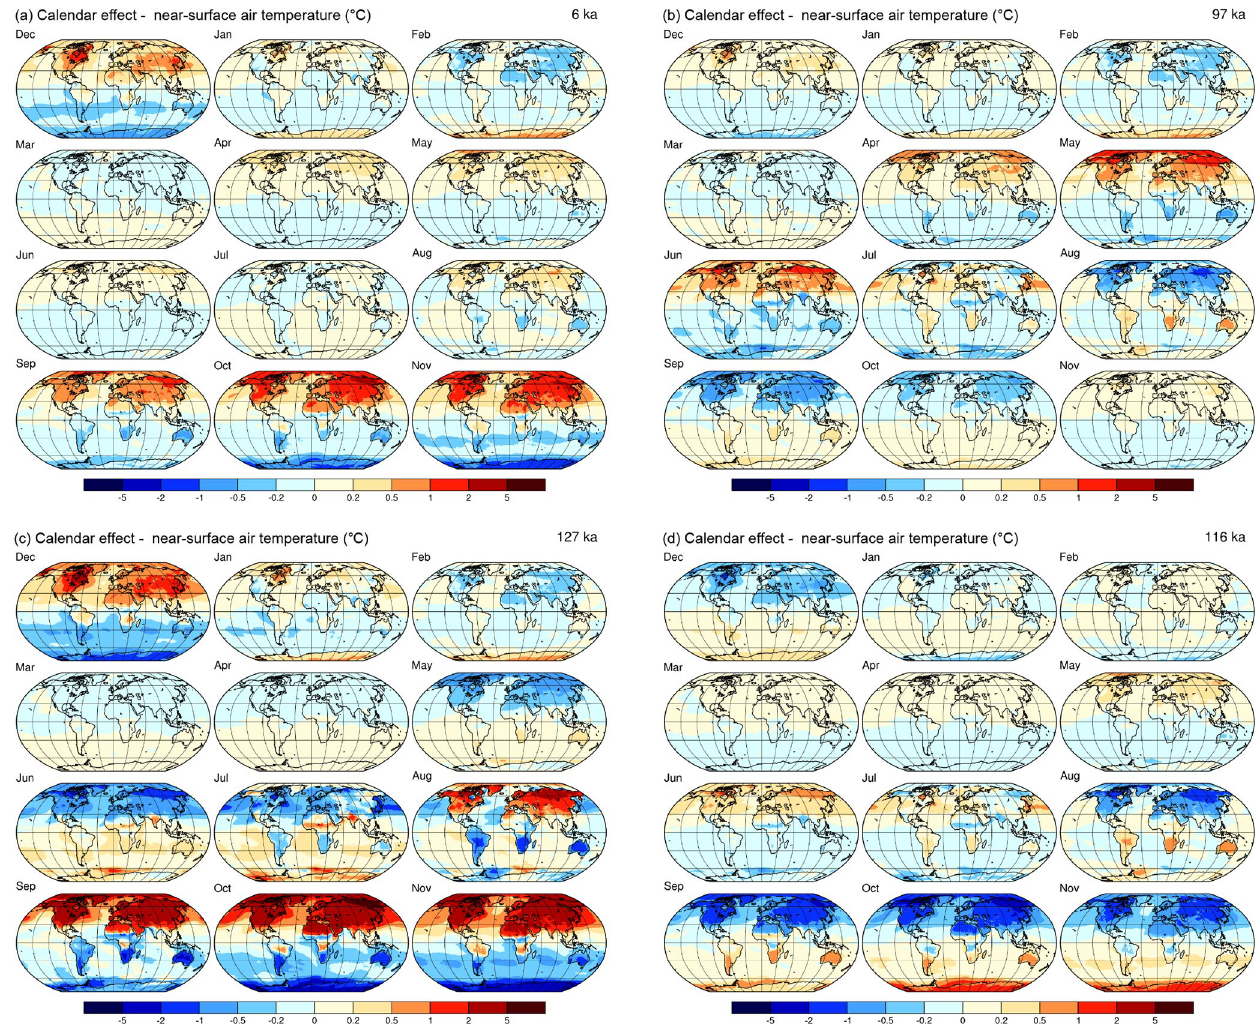
Figure 11. Calendar effects on near-surface air temperature for 6ka (a) , 97ka (b) , 127ka (c) , and 116ka (d) . The maps show the patterns of month-length adjusted average temperatures minus the unadjusted values using 1981–2010 long-term averages of CFSR tas values, with positive differences (indicating that the adjusted data would be warmer than unadjusted data) in red hues and negative differences in